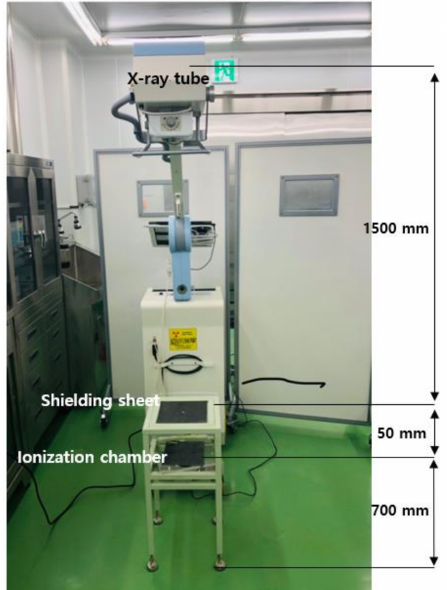
Figure 4. Experimental setup for evaluating the shielding efficiency of the sheet